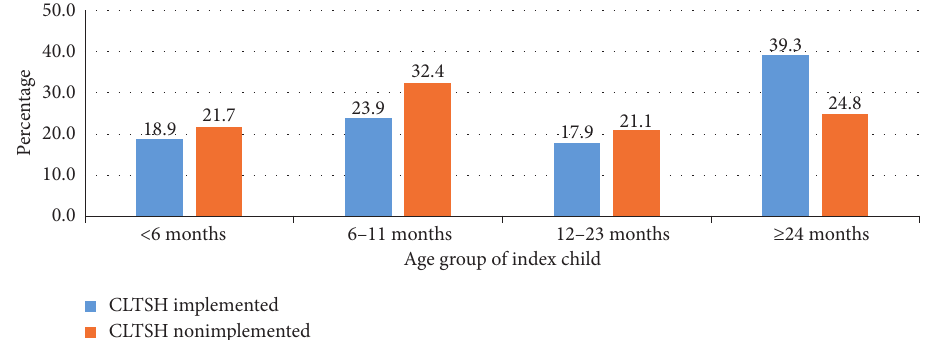
Figure 2: Bar chart shows the prevalence of age of index child among under-five in CLTSH implemented and nonimplemented areas in Gamo Gofa Zone, March Table 2: The sociodemographic characteristics in selected CLTSH implemented and nonimplemented woreda in Gamo Gofa Zone, 2018. Variables